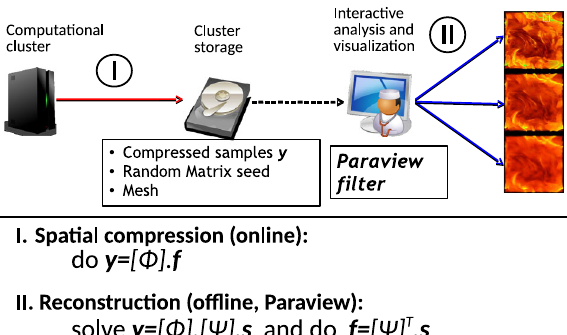
Fig. 3 A schematic showing the major steps during the in situ data compression using CS ( I ) and the offline reconstruction and visualization of the original dataset ( II ) using ParaView. The random seed, the mesh and the compressed samples y are transferred to the visualization platform where the reconstruction of f takes